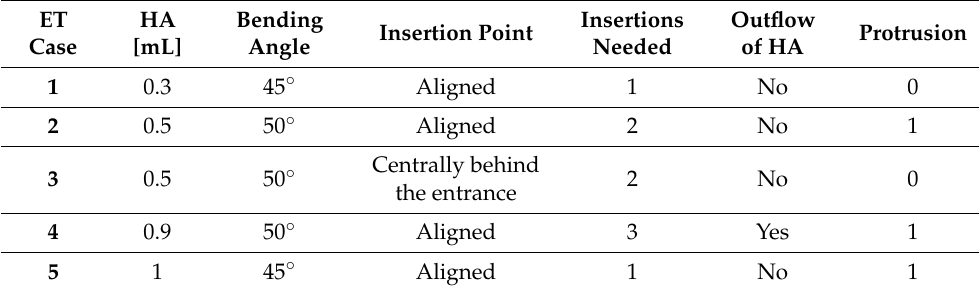
Table 2. In vivo cases injected with non-stabilized HA in chronological order.